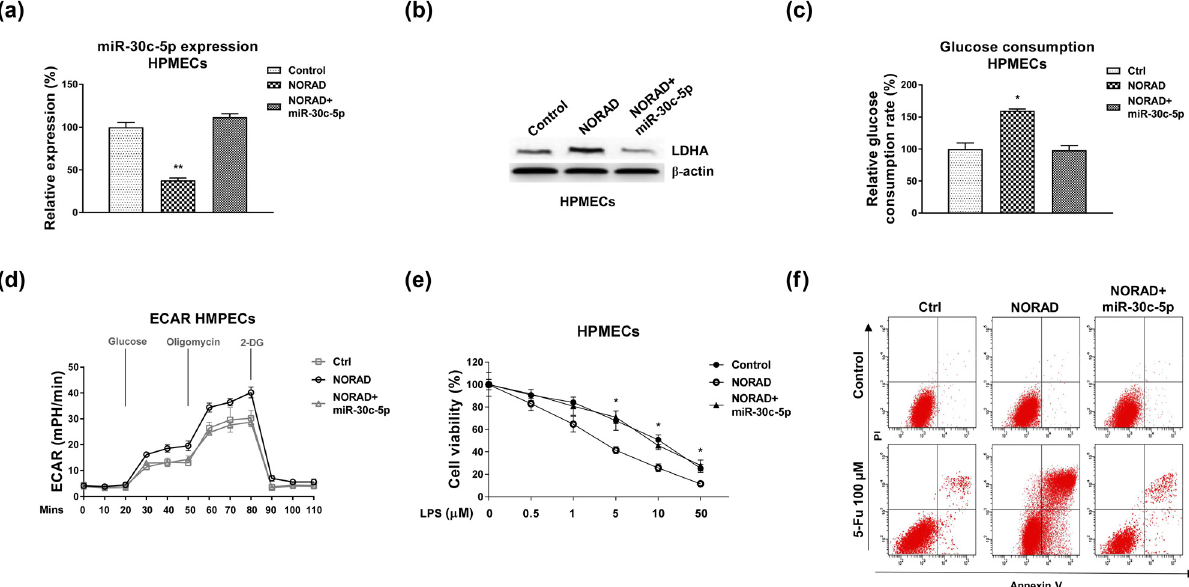
Figure 7: Roles of the NORAD - miR - 30c - 5p - LDHA axis in the LPS - induced HPMECs dysfunction. ( a ) HPMECs were transfected with control, NORAD alone, or with miR - 30c - 5p. Expressions of miR - 30c - 5p and ( b ) LDHA were examined by qRT - PCR and western blot, respectively. ( c ) The glucose consumption and ( d ) ECAR were examined in the above transfected cells. ( e ) HPMECs were transfected with control, NORAD, NORAD plus miR - 30c - 5p were treated with control or LPS. Cell survival rates were determined by MTT assay and ( f ) Annexin V apoptosis assay. *, p < 0.05; **, p <